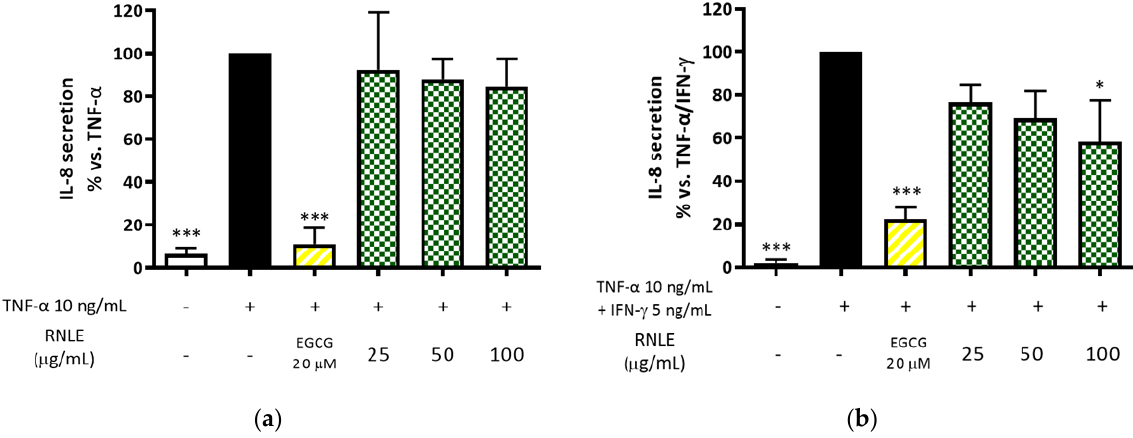
Figure 5. ( a ) Effect of RNLE treatment (25–100 µg/mL) on IL-8 secretion in HaCaT cells stimulated with TNF-α (10 ng/mL, 24 h); the amount of IL-8 in the stimulated condition was 211.31 ± 34.26 pg/mL. ( b ) Effect of RNLE treatment (25–100 µg/mL) on IL-8 secretion in HaCaT cells stimulated with a combination of IFN-γ and TNF-α (5 ng/mL + 10 ng/mL, 24 h); the amount of IL-8 in the stimulated condition was 1084.66 ± 118.62 pg/mL. (−)-Epigallocatechin 3-gallate (EGCG) 20 µM was used as the reference compound; * p < 0.05, *** p < 0.001 vs. stimulus.